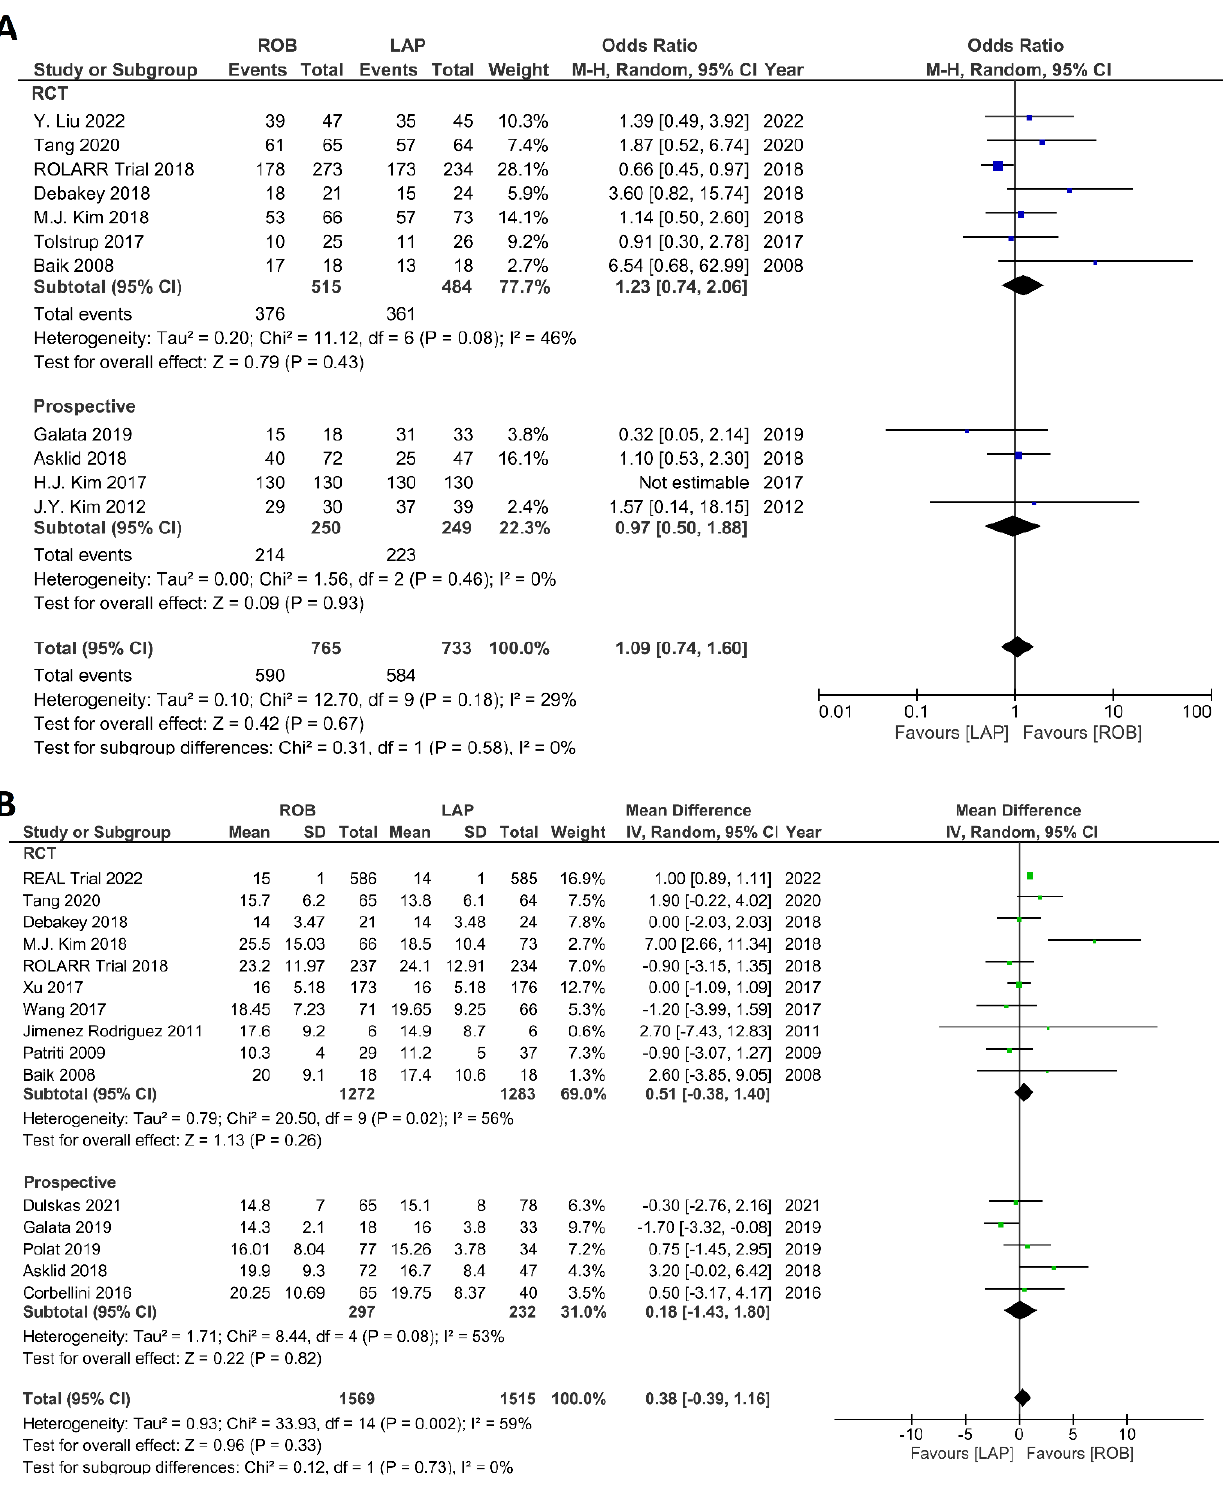
Figure 11. Forest plots comparing ( A ) TME completeness [6,17,19,23,34,35,38,43,45,48–50] and ( B ) total harvested lymph nodes [6,17–19,23,34–37,39–41,45,47,48,52] between robotic and laparo- scopic rectal resection (blue boxes representing odd ratios, green boxes representing mean differences, arrows representing 95% confidence intervals, and diamonds representing point estimates of pooled odd ratios or mean differences).